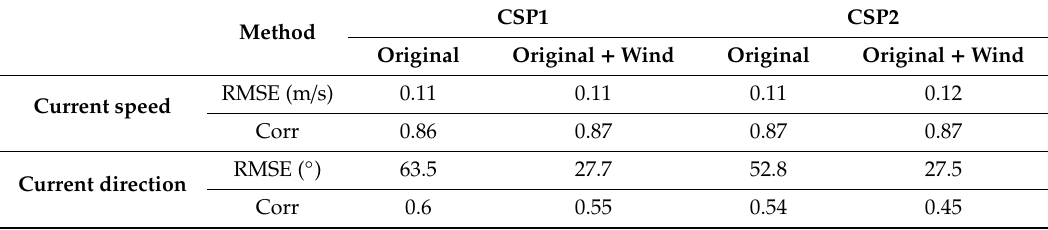
Figure 7. ( a ) The Stokes drift at di ff erent depths, and ( b ) the estimated wind speed and sea surface Ekman current. Table 2. The root mean squared error (RMSE) and correlation coe ffi cient (Corr) between the current speed and current direction measured by current meter and those retrieved from X-band marine radar images using two